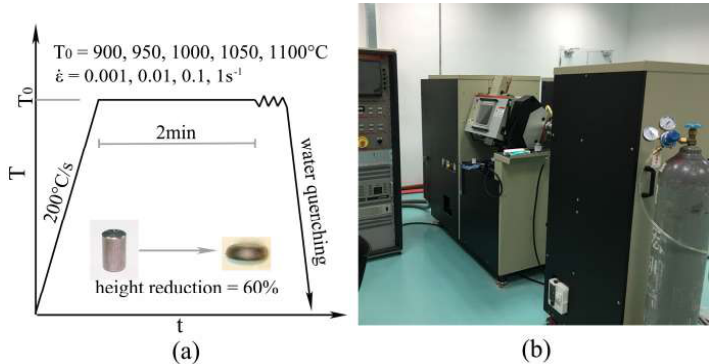
Figure 1. Schematic of the experimental procedure ( a ) time‐temperature curve; and ( b ) experiment